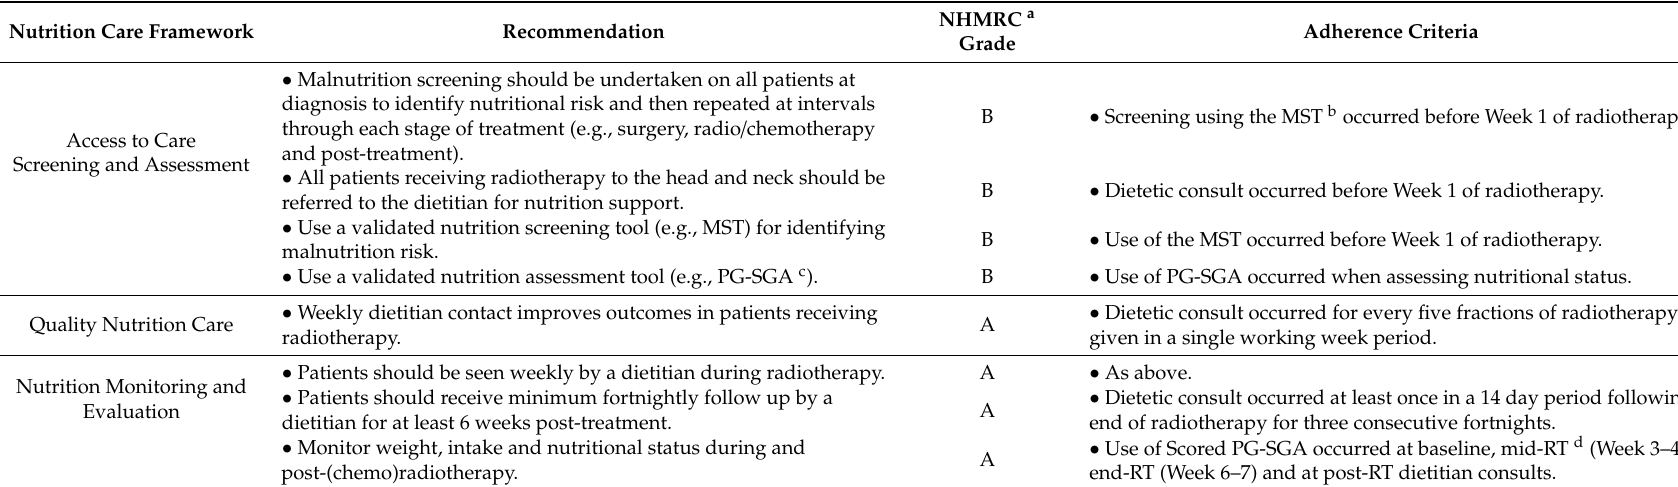
Table 1. Evidence-based guideline recommendations and adherence